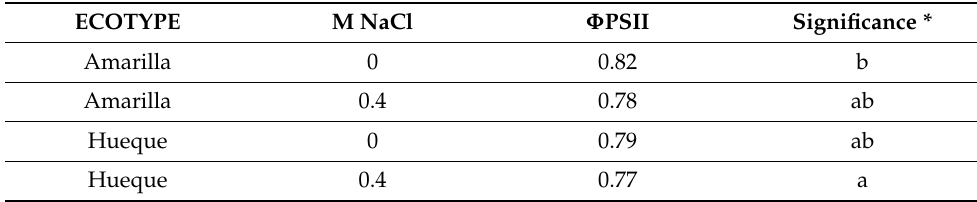
Table 6. Quantum efficiency of